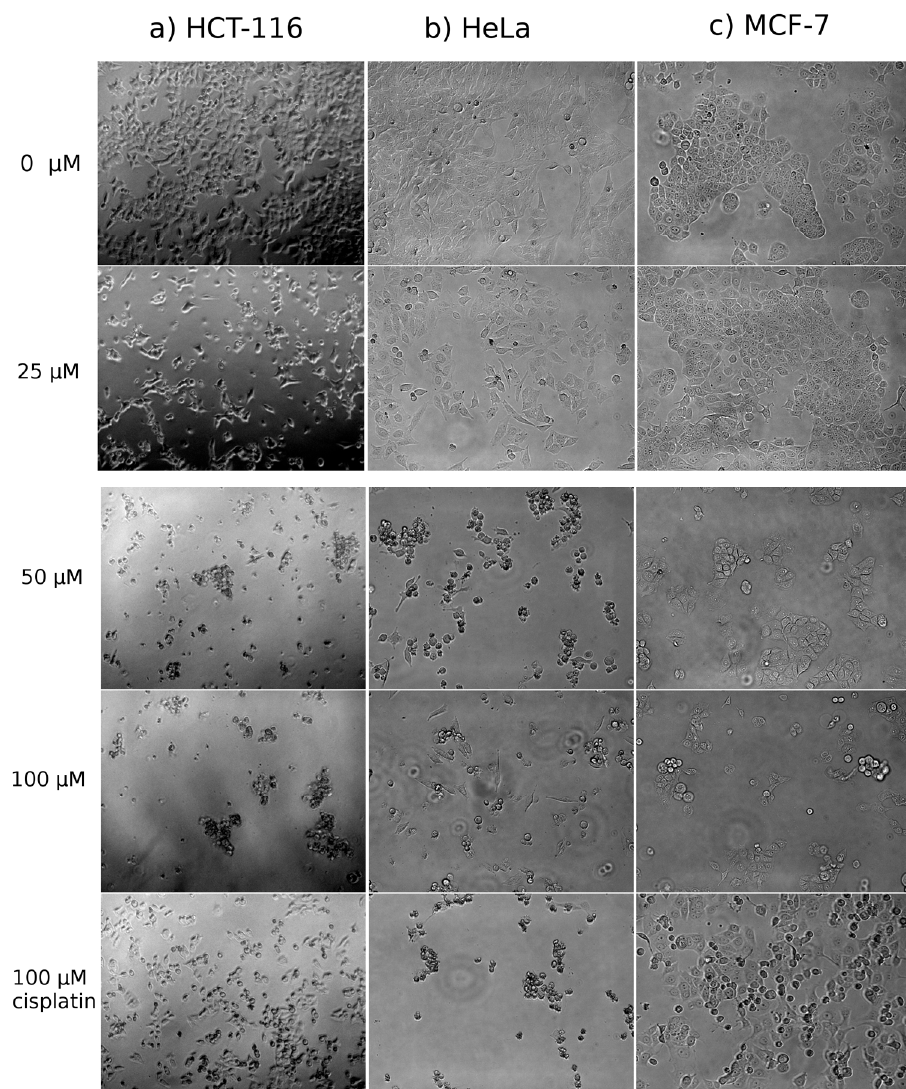
Figure 3. Morphology of cell lines: HCT-116 ( a ); HeLa ( b ) treated with 37 (0–100 μ M) and cisplatin (100 μ M); MCF-7 ( c ) treated with 46 (0–100 μ M) and cisplatin (100 μ M). Light microscopy photographs, with 10× objective, of cells treated for 24 h.